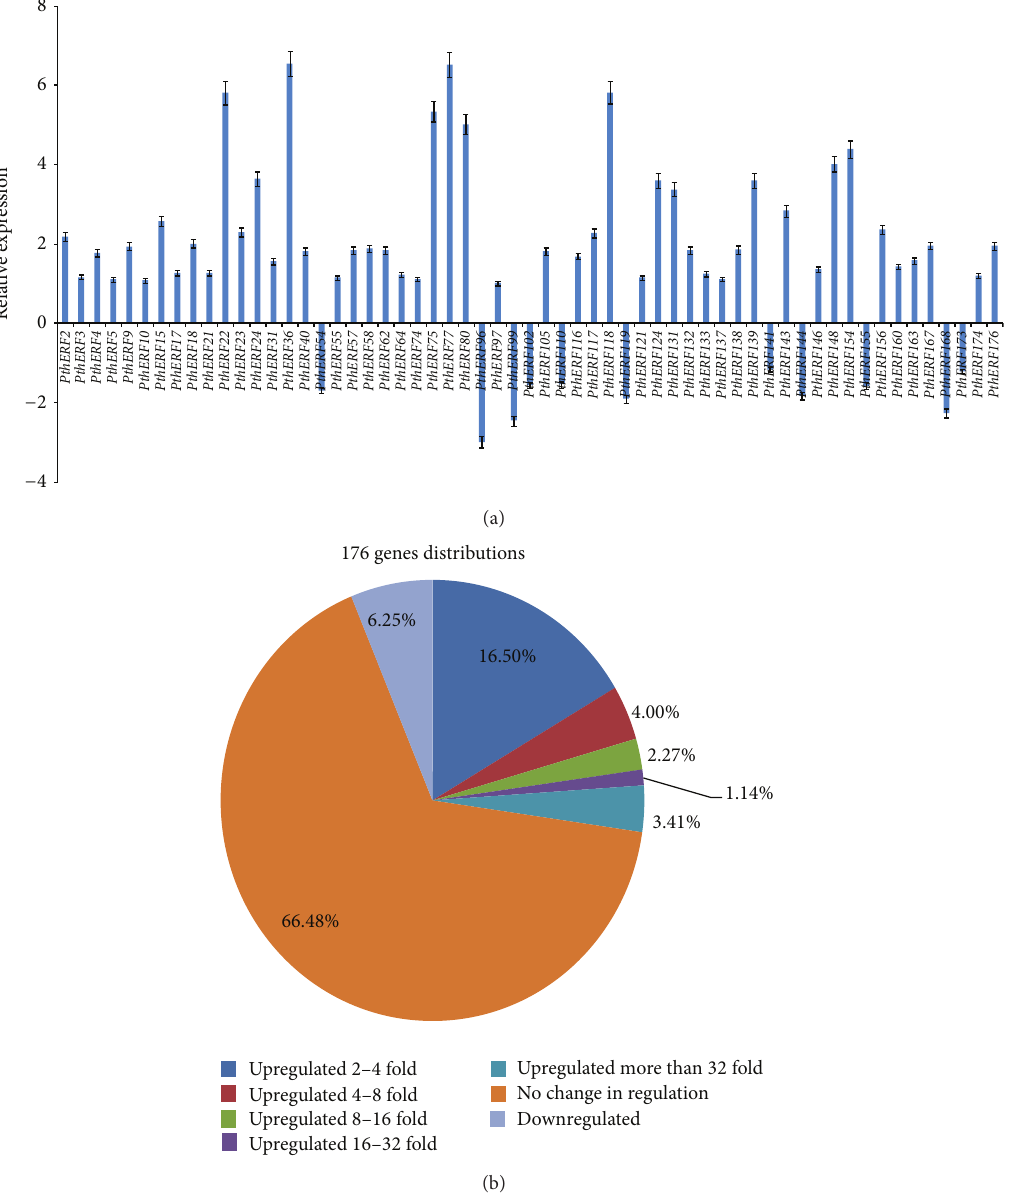
Figure 1: Expression trends of 176 Populus ERF genes in response to NaCl stress in the leaves by RT-PCR analysis. Relative expression level was log 2 transformed: > 0: upregulation; =0: no change in regulation; < 0: downregulation. (a) Expression patterns of 59 responsive PthERFs ; (b) 176 ERF genes distributions: 66.48% were no change in regulation; 6.25% were downregulated; the rest were upregulated in different